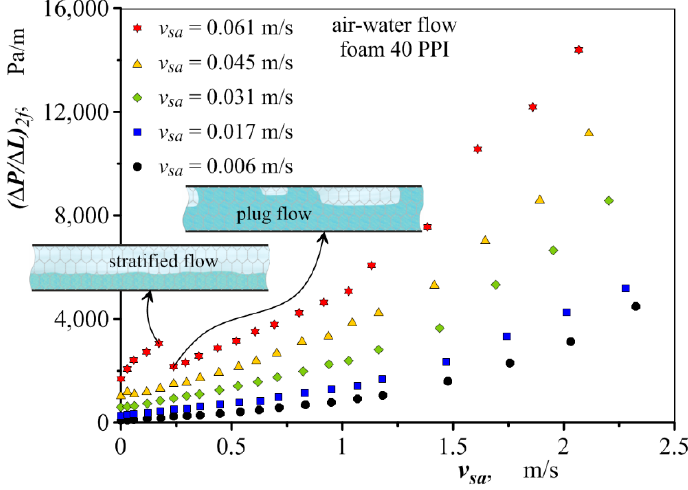
Figure 8. Cellular skeleton of foams used in this research: ( a ) 30 PPI foam; ( b ) 40 PPI foam; ( c ) local deformation of the cellular skeleton of 40 PPI foam.